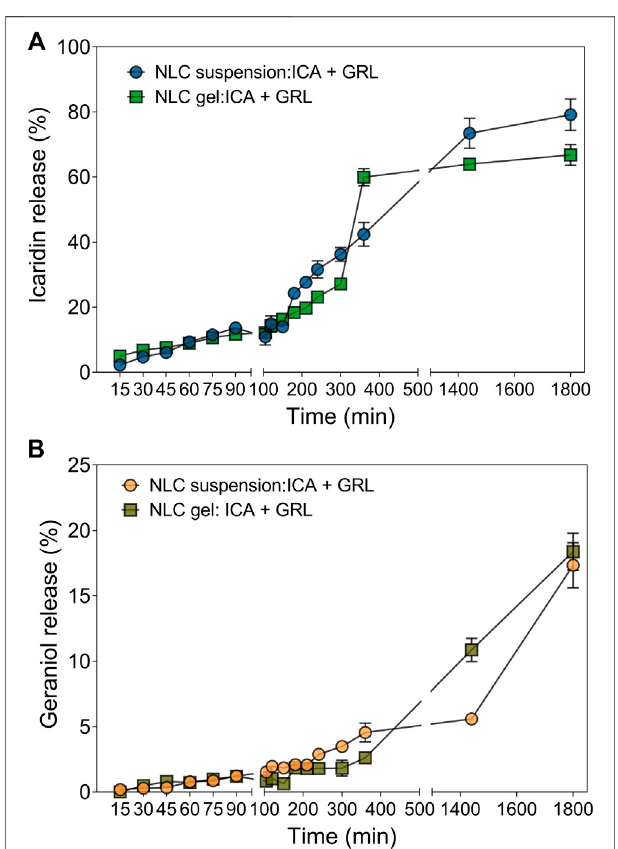
FIGURE 4 | Cumulative release pro fi les for the repellents in the suspension and gel formulations. The NLCs contained 2% geraniol (GRL) and 5% icaridin (ICA). The system was maintained under magnetic stirring (300 rpm), at 32.5 ° C, for 32 h. The analyses were performed in triplicate (the values are shown as mean ±